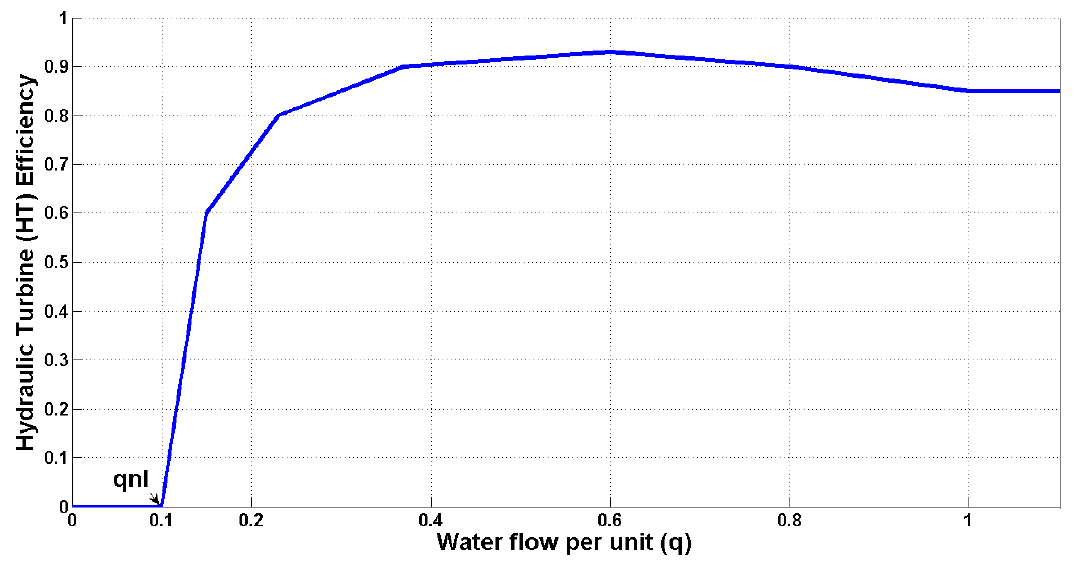
Figure 2. Pelton hydro turbine efficiency.